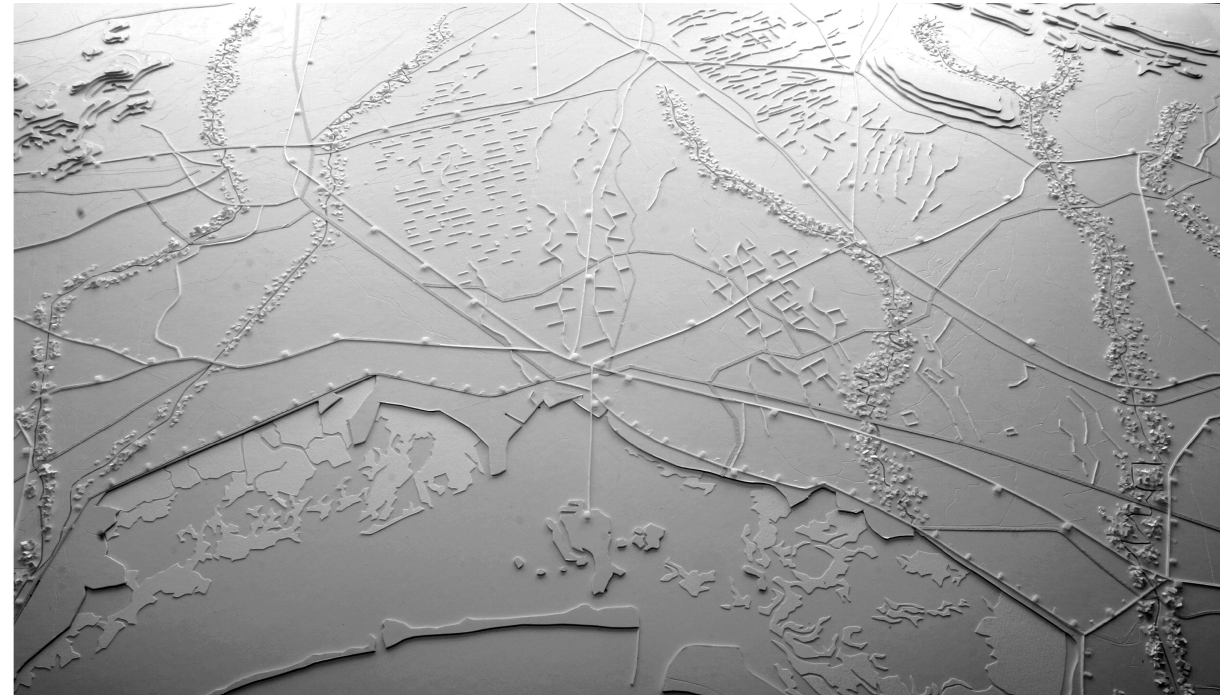
Figure 1. Isotropy as a figure of political rationality. Source: Viganò, Secchi, and Fabian (2016). Image credits due to B. Secchi, P. Viganò and IUAV PhD students at “Water and Asphalt,” Venice Architecture Biennale,